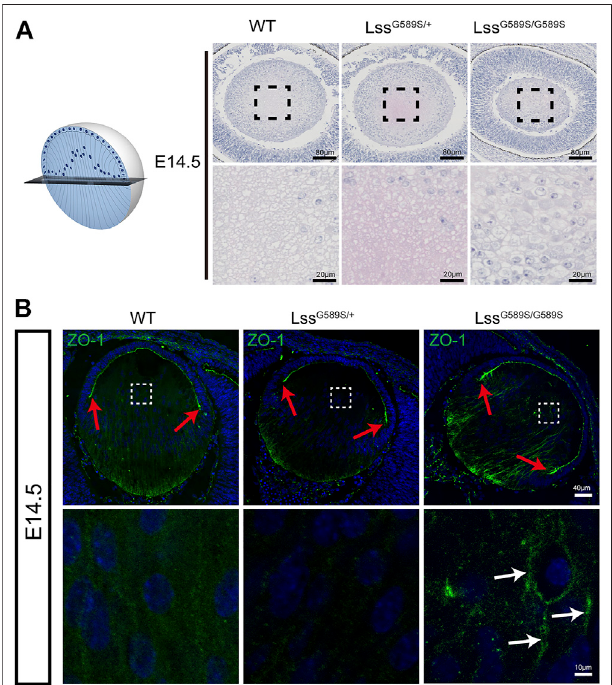
FIGURE 8 | Disrupted polarity of lens fi ber cells in Lss G589S/G589S mice. (A) Alignment of lens fi ber cells stained with hematoxylin and eosin and distribution of cell nuclei in sagittally sectioned lenses in the equator plane of WT, Lss G589S/+ , and Lss G589S/G589S mice at E14.5. Scale bar: 80 μ m. The enlargement is the magni fi cation of the boxed inset shown in the upper panel.Scalebar:20 μ m. (B) TheexpressionofZO-1inlensofWT,Lss G589S/+ , and Lss G589S/G589S mice at E14.5. Scale bar: 40 μ m. The enlargement is the magni fi cation of the boxed inset shown in the upper panel. Red arrows indicate lens fulcrums. White arrow indicates that ZO-1 was strongly retained inthezonesbetweenlens fi bercellsofLss G589S/G589S mice.Scalebar:10 μ